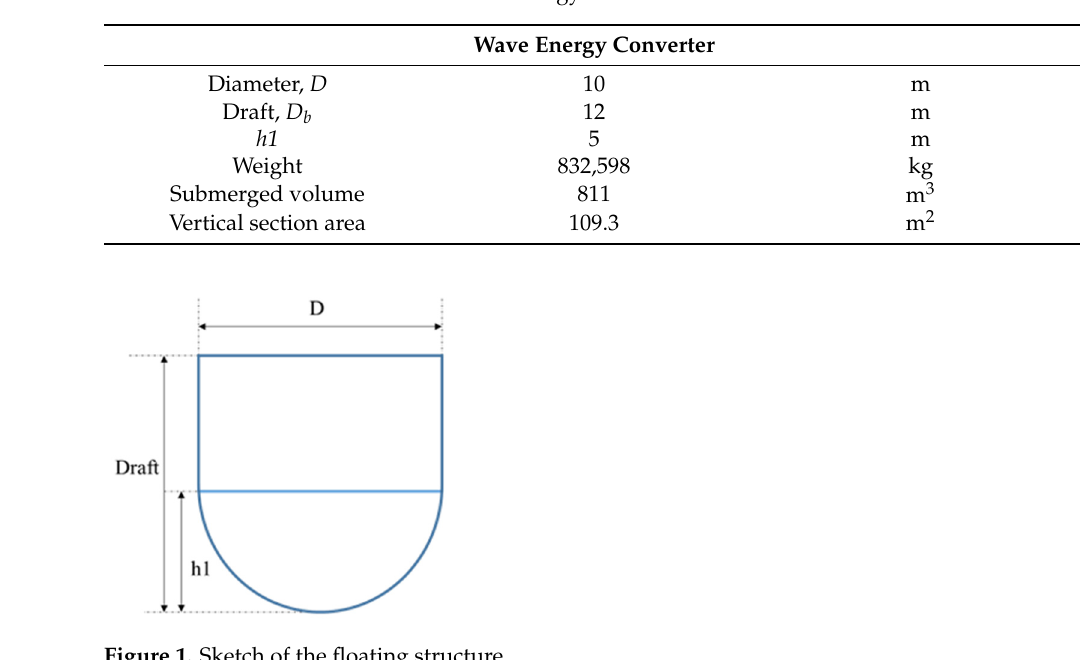
Table 1. Main characteristics of the wave energy converter.